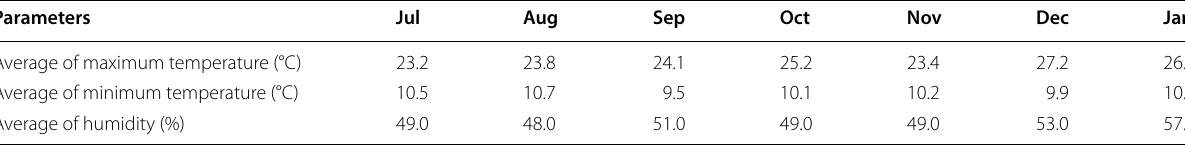
Table. 1 Meteorological data from weather station of Egerton University